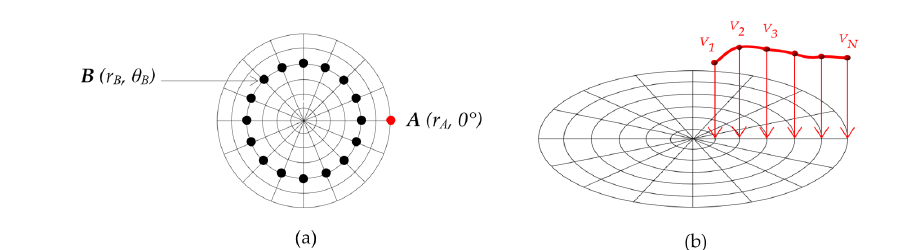
Figure A1. ( a ) Illustration of disk setup. Point A represents the center of a location at zeroth azimuth ( θ = 0 ◦ ) and radius r A . Point B represents the center of a location at radius r B and azimuthal angle θ B. The polar coordinates of points A and B are ( r A , 0 ◦ ) and ( r B , θ B ), respectively. ( b ) Illustration of DM2 input. RC values are used to set model